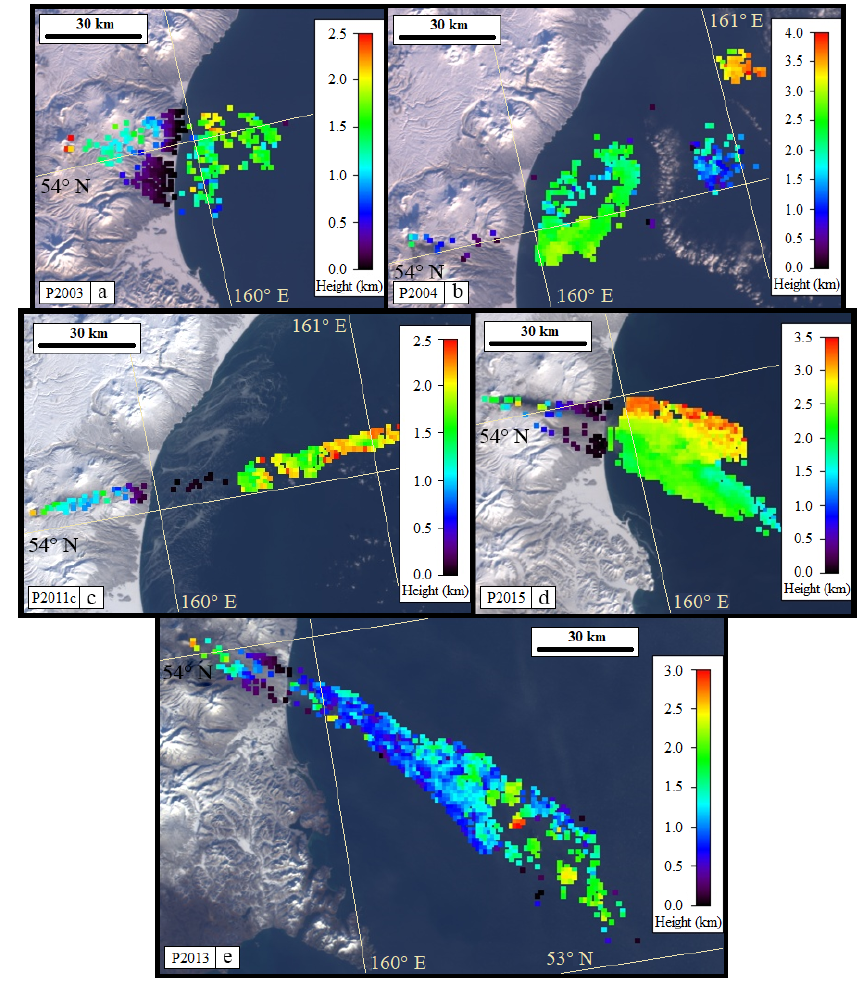
Figure 2. MISR stereo height retrieval maps derived using the MISR INteractive eXplorer (MINX). Class 1 plumes (low MeNspWab) emitted from Karymsky volcano on (a) 27 December 2003 (orbit: 21402; path: 99; block: 47), (b) 12 January 2004 (orbit: 21635; path: 99; blocks: 46–47), (c) 27 February 2015 (orbit: 80817; path: 99; blocks: 47–48), (d) 18 February 2011 (orbit: 59410; path: 97; block: 46–47) and